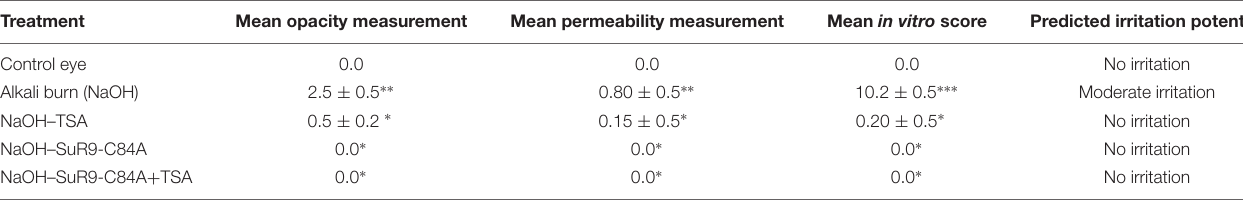
TABLE 1 | Measure of opacity, permeability, and